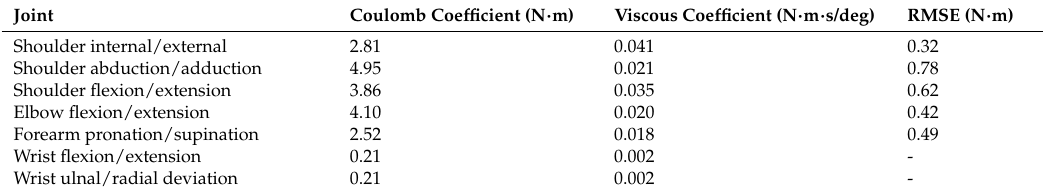
Figure 4. Experimental calibration results of the friction models of exoskeleton joints. ( a ) Shoulder internal/external. ( b ) Shoulder abduction/adduction. ( c ) Shoulder flexion/extension. ( d ) Elbow flexion/extension. ( e ) Forearm pronation/supination. Table 2. Identification results for the parameters of Coulomb-viscous friction